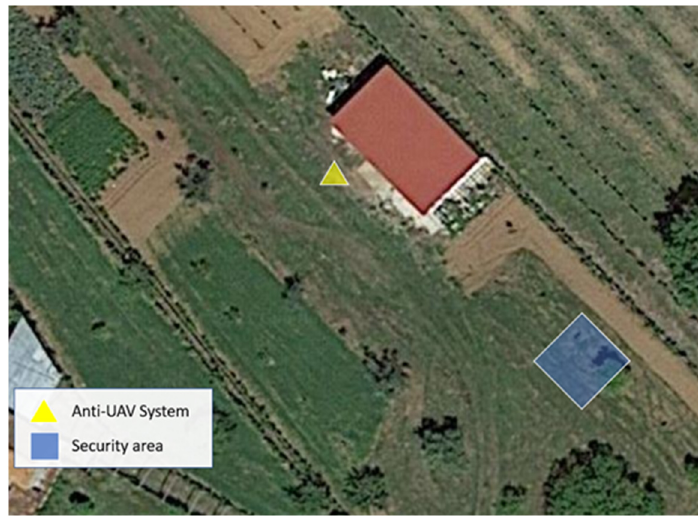
Figure 11. Real test scenario with selected forced landing site.